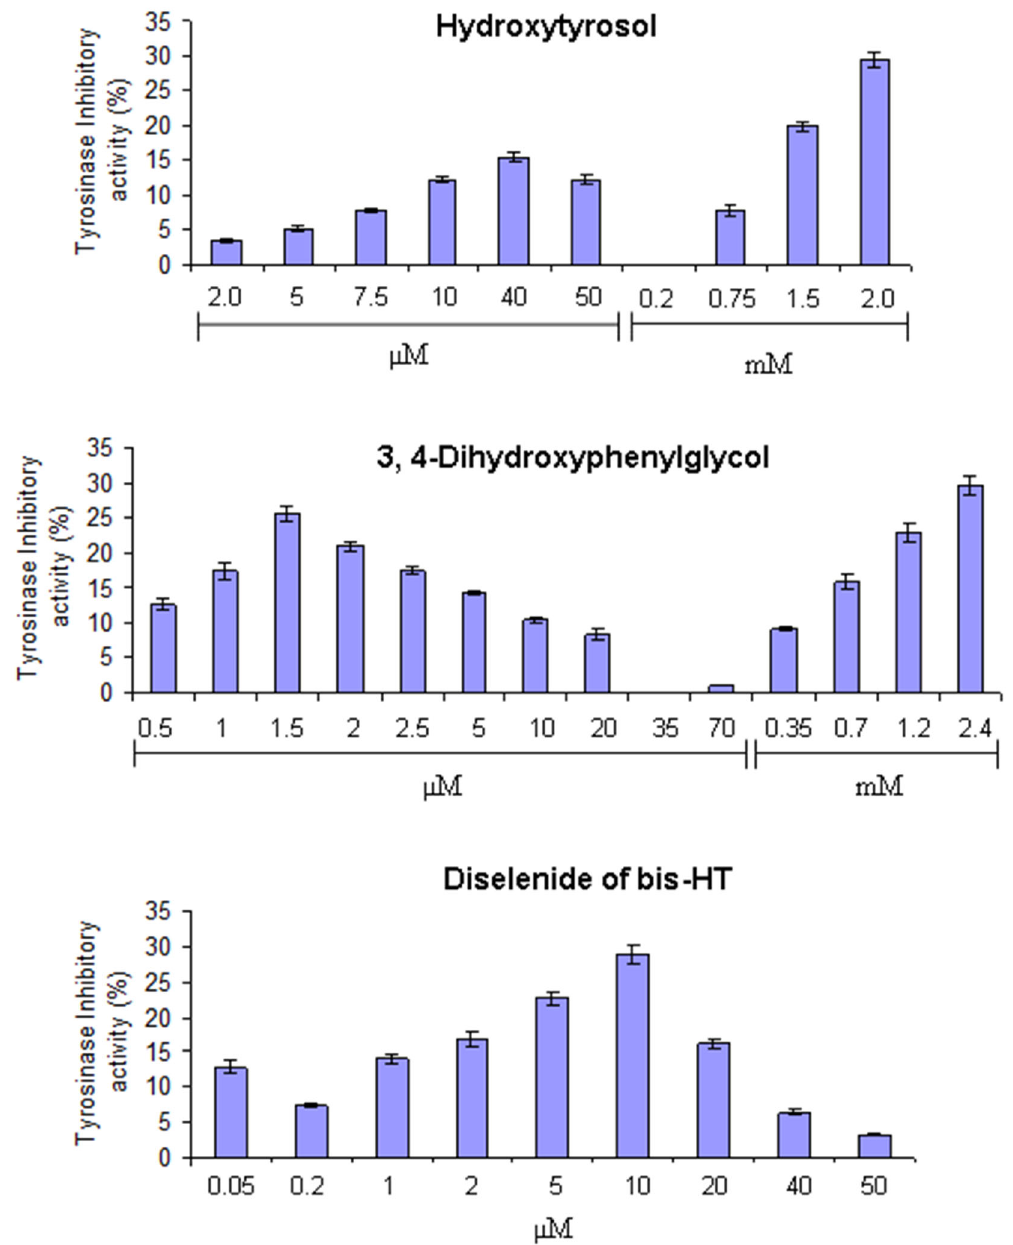
Figure 3. Tyrosinase-inhibitory activity (%) of hydroxytyrosol (HT), 3,4-dihydroxyphenylglycol (DHPG), and dihydroxytyrosyl diselenide (diselenide of bis-HT). Bars represent standard deviations (n = 3). The values showed significant differences ( p ≤ 0.05) for all tested concentrations except for 0.05 and 1 μ M of diselenide of bis ‐ HT.